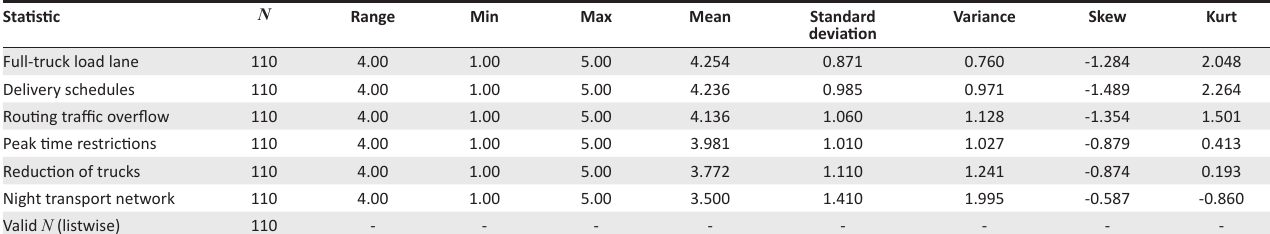
TABLE 1: Descriptive statistics on strategic optimisation factors.